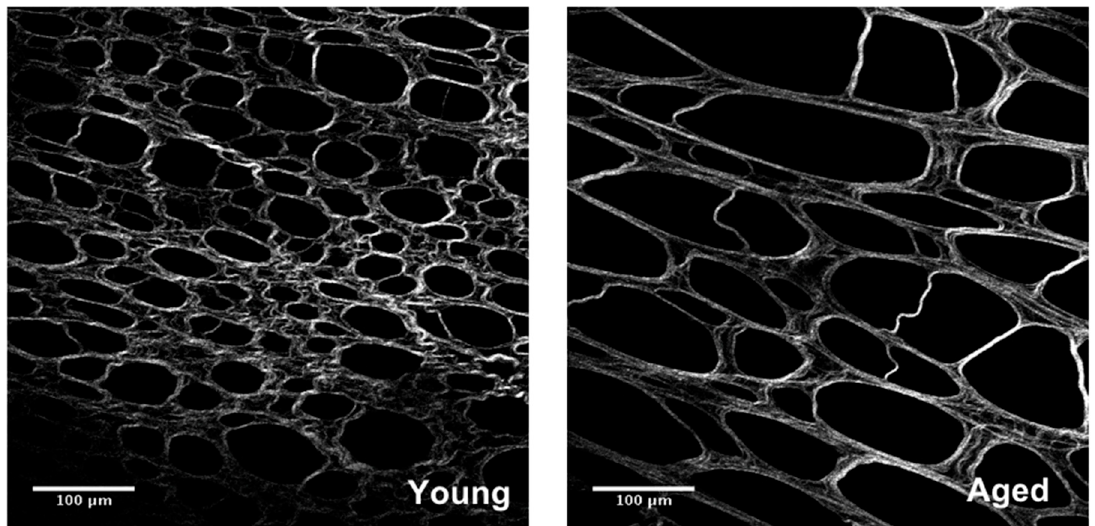
Figure 2. Age-related changes in omental collagen structure. Second harmonic generation imaging of omental tissue isolated from young and aged mice shows a distinct difference in structure. Aged collagen forms crosslinks that result in the loss of meshwork, formation of tendon-like structures and increased anisotropy. This causes a disruption of tissue structure that can affect how metastasizing OvCa cells interact with the tumor microenvironment.